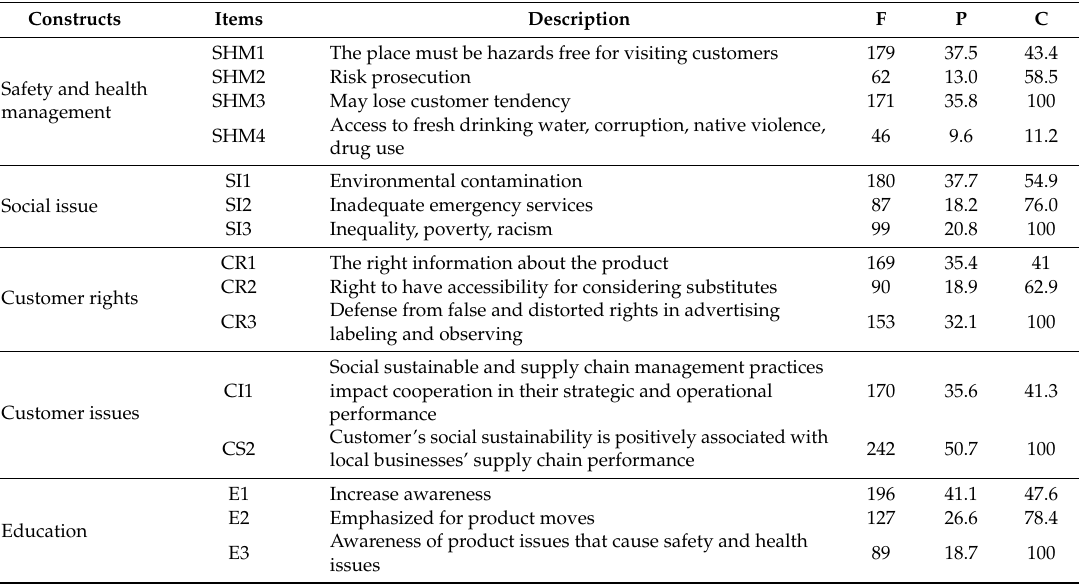
Table 5. Social Sustainable dimensions of customers.